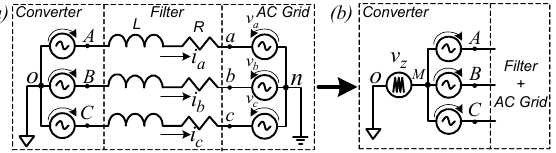
Figure 3. Equivalent circuit of three-phase three-wire grid-connected VSCs, considering Z g = 0 Ω Figure 3. Equivalent circuit of three ‐ phase three ‐ wire grid ‐ connected VSCs, considering Z g = 0 Ω and then e abc = v abc . ( a ) Power system modeling, and ( b ) power convert modeling. and then e abc = v abc . ( a ) Power system modeling, and ( b ) power convert modeling. Some strategies that employ controllers in the natural frame are described in Section